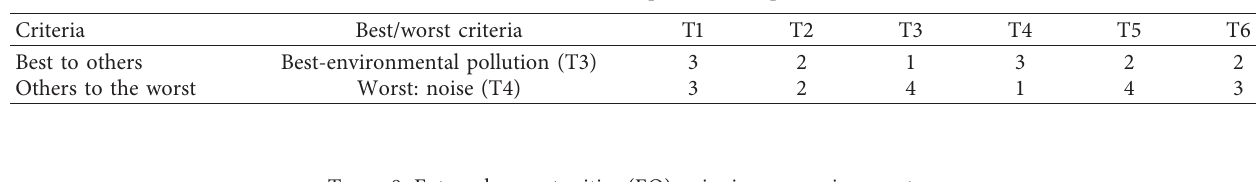
Table 7: External threats (ET)-pairwise comparison vector.